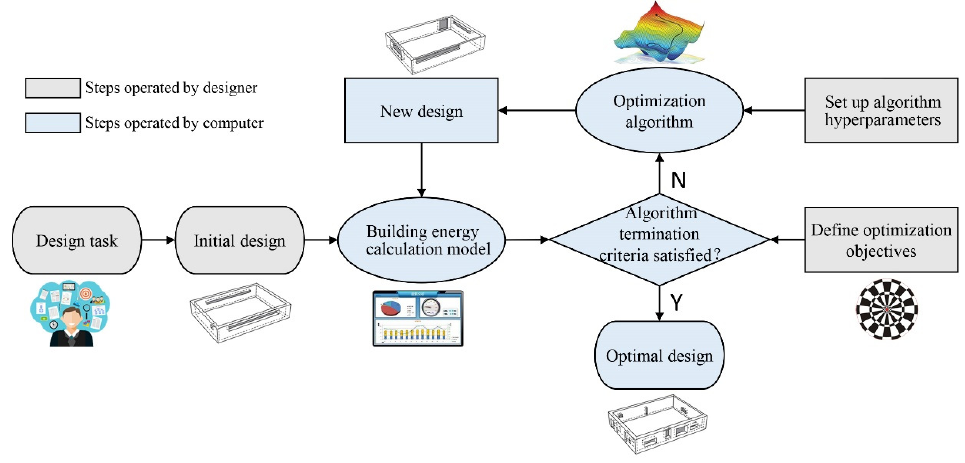
Figure 1. General workflow of the BEO technique.